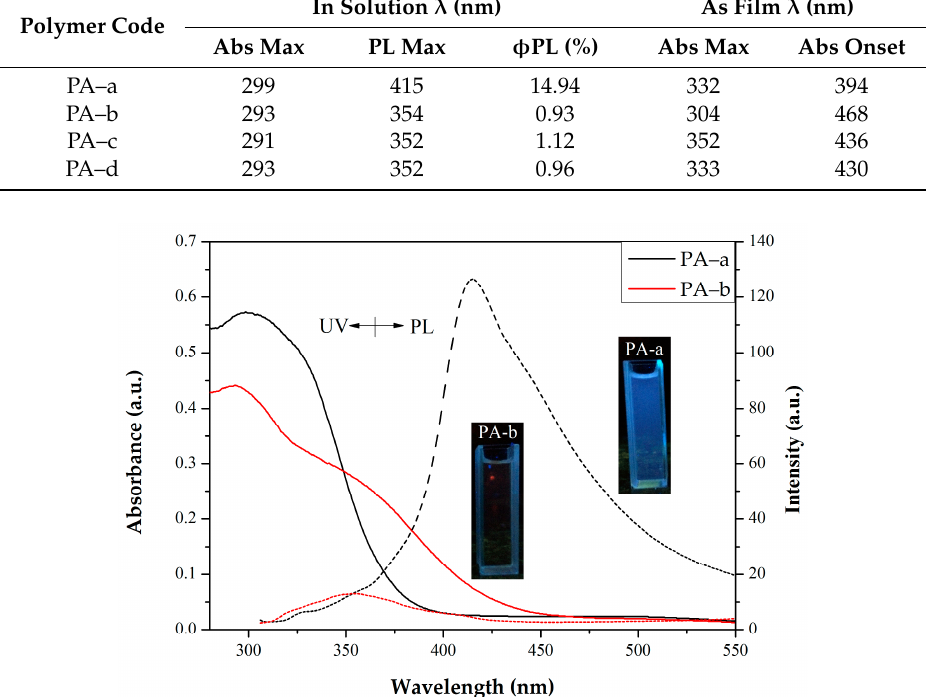
Figure 2. UV-vis (the solid line) and PL (the dotted line) spectra of the PA–a and PA–b in DMSO solutions (1 × 10 − 5 M) with inset taken under irradiation of 365 nm UV light. Table 2. Optical properties of PAs.